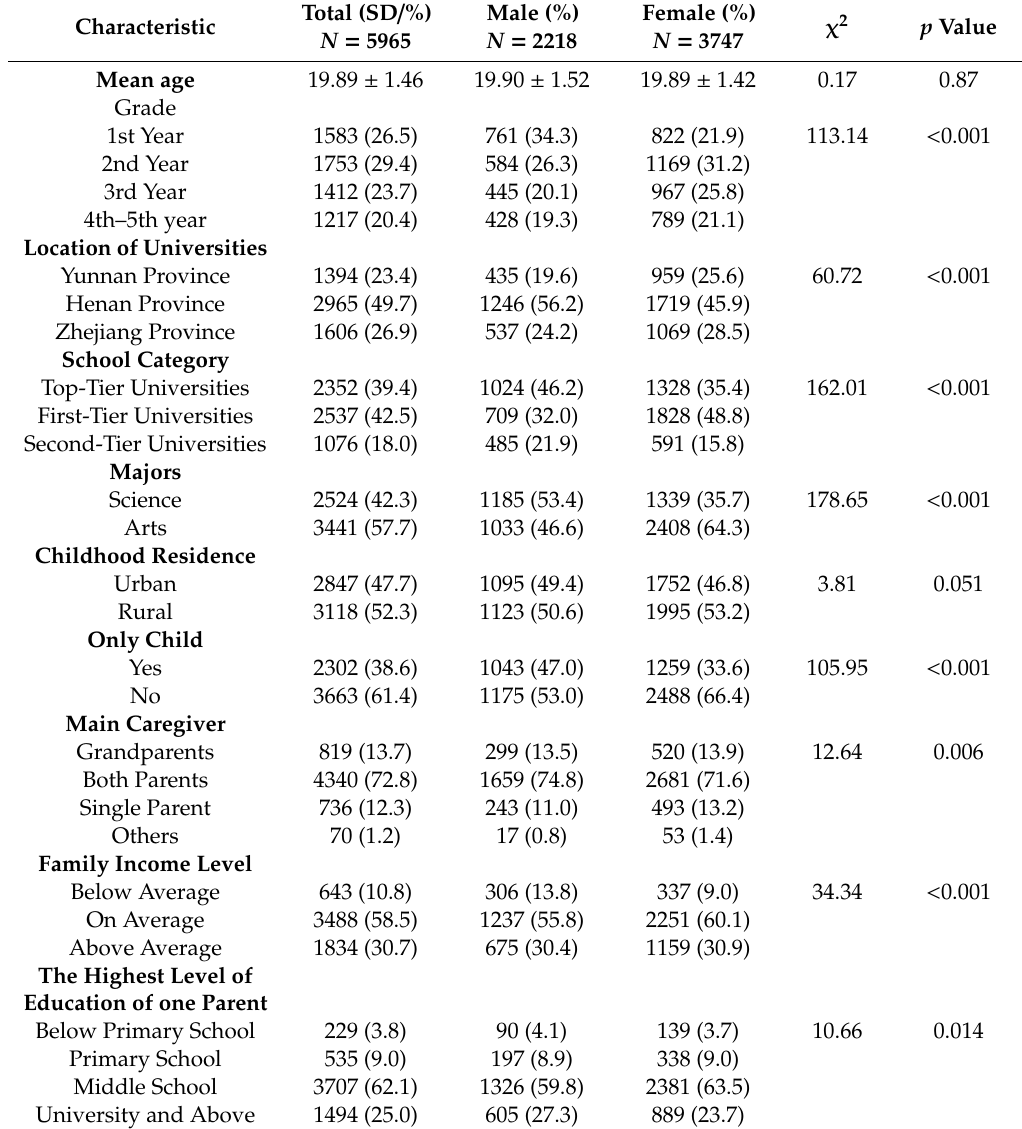
Table 1. Socio-demographic characteristics of respondents.